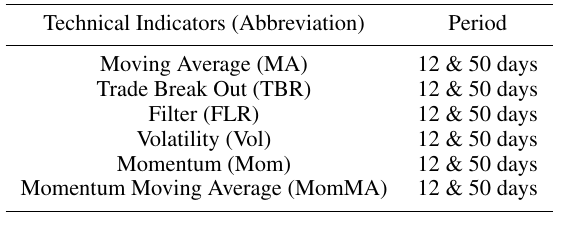
Table 1 Technical Indicators used by EDDIE 7. Each indi- cator uses 2 different periods, 12 and 50, in order to take into account a short-term and a long-term period. For complete- ness, we provide formulas of our interpretation for these in- dicators in the Appendix.